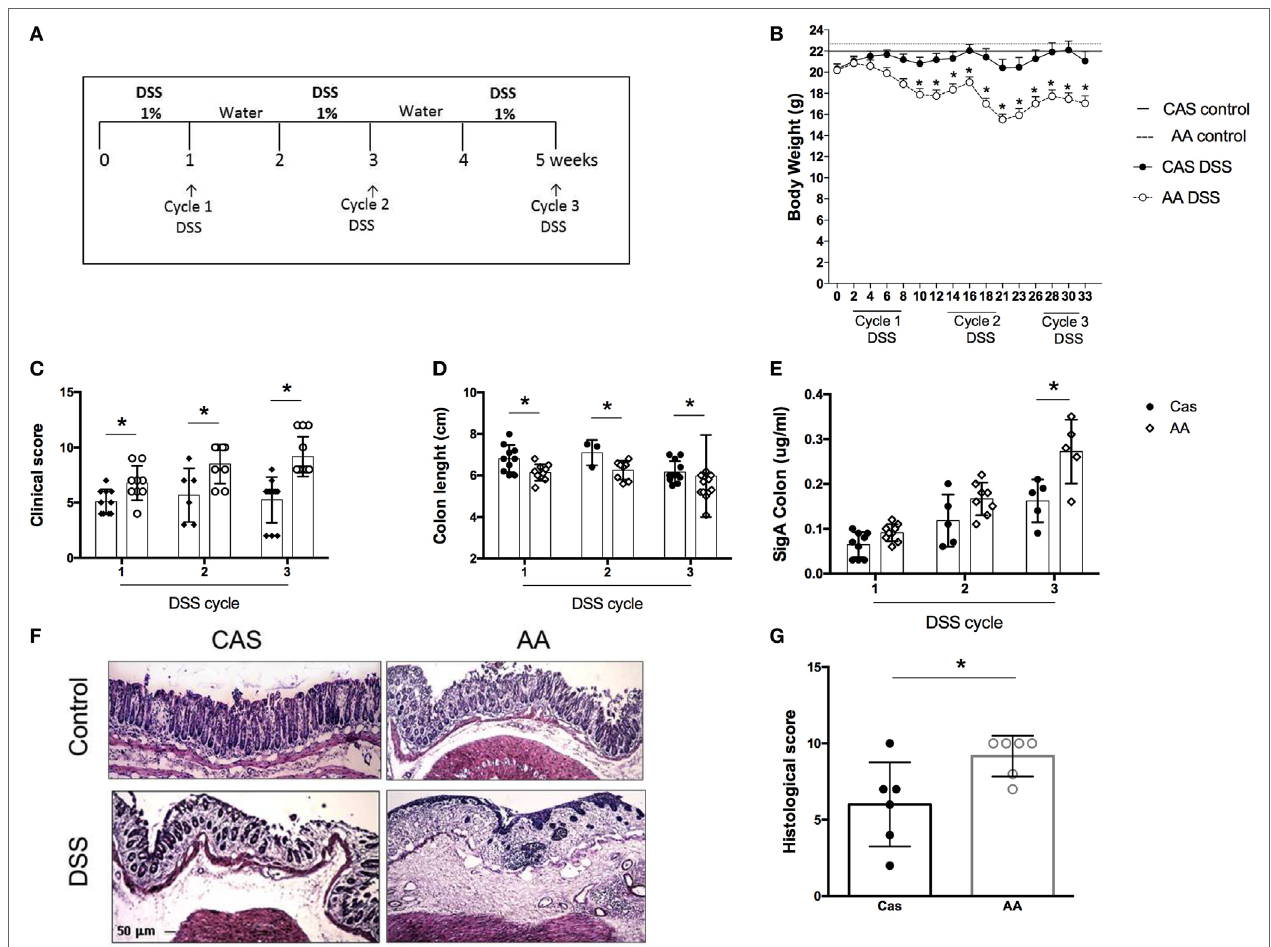
FigUre 5 | Effects of dietary consumption during dextran sodium sulfate (DSS)-induced colitis development. C57BL/6 mice at 7–8 weeks of age were introduced at experimental diet [diet containing free amino acids (AA) diet] or control [casein-containing diet (CAS)] diet. All mice were kept on these diets throughout colitis induction. Colitis was induced by three-cycle administration of 1% (w/v) DSS in drinking water for 7 days, alternated with 7-day recovery periods (a) . Weight loss was evaluated during colitis development (b) . Clinical scores of mice with colitis were performed after each cycle of DSS using a scoring system which includes loss of body weight, diarrhea, and presence of blood in the stools (c) . Colon length was evaluated after each cycle of DSS (D) . SIgA levels were measured in the colonic lavage fluid by enzyme-linked immunosorbent assay (ELISA) (e) at the end of each cycle of DSS. Representative images colon of CAS-fed and AA-fed mice (F) are shown. Histological scoring (g) was performed on samples of the distal colon considering the extent of mucosal architecture destruction, presence and degree of cellular infiltration, extent of muscle thickening, presence or absence of crypt abscesses and presence or absence of goblet cell depletion at the end of the third cycle of DSS ( n = 5–12). Statistical analysis was performed between CAS-fed and AA-fed group at the end of each experimental time point using Student’s t test for parametric data and Mann–Whitney for non-parametric data. p <